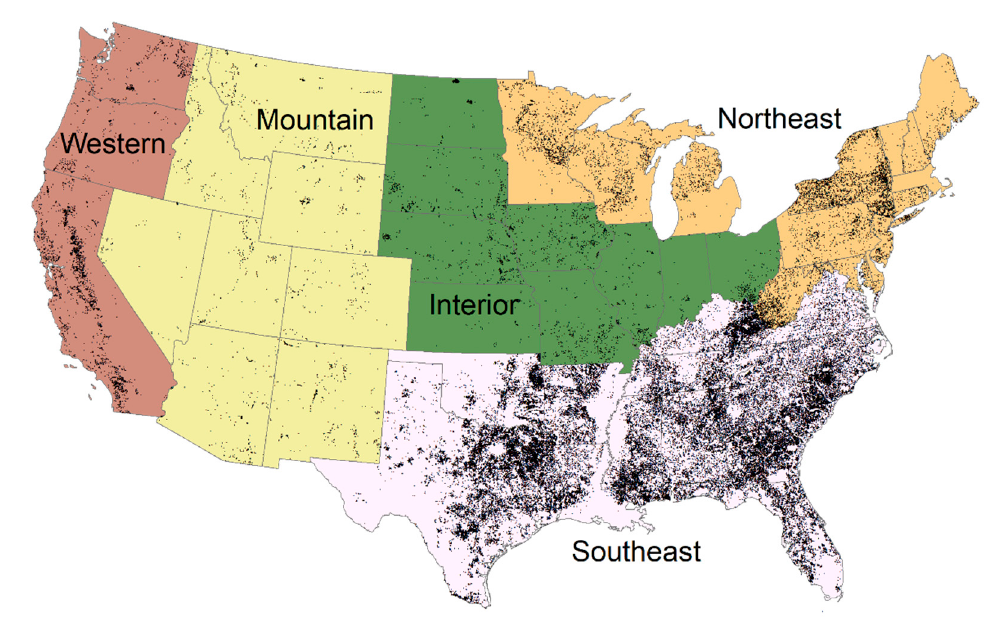
Figure 1. Regions with occurrences of fire > 0.4 ha during 2008–2012.